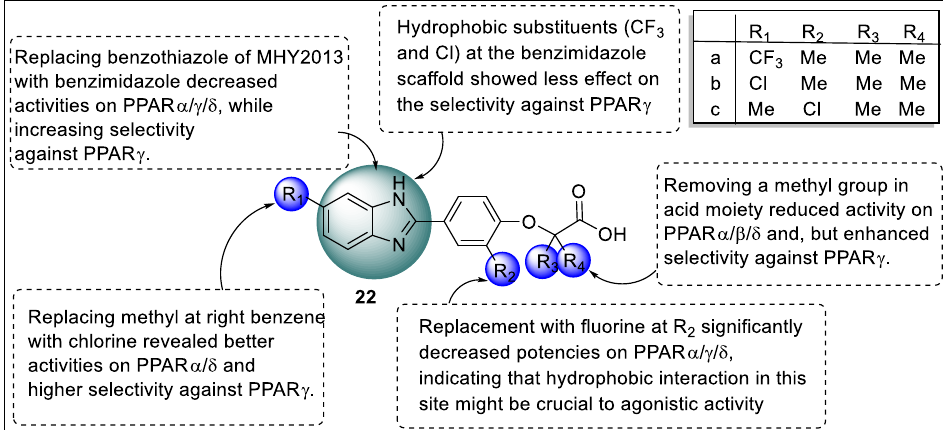
Figure 25. Structural activity relationship of Benzimidazole hybrids ( 22 ) as potent PPAR ligands.